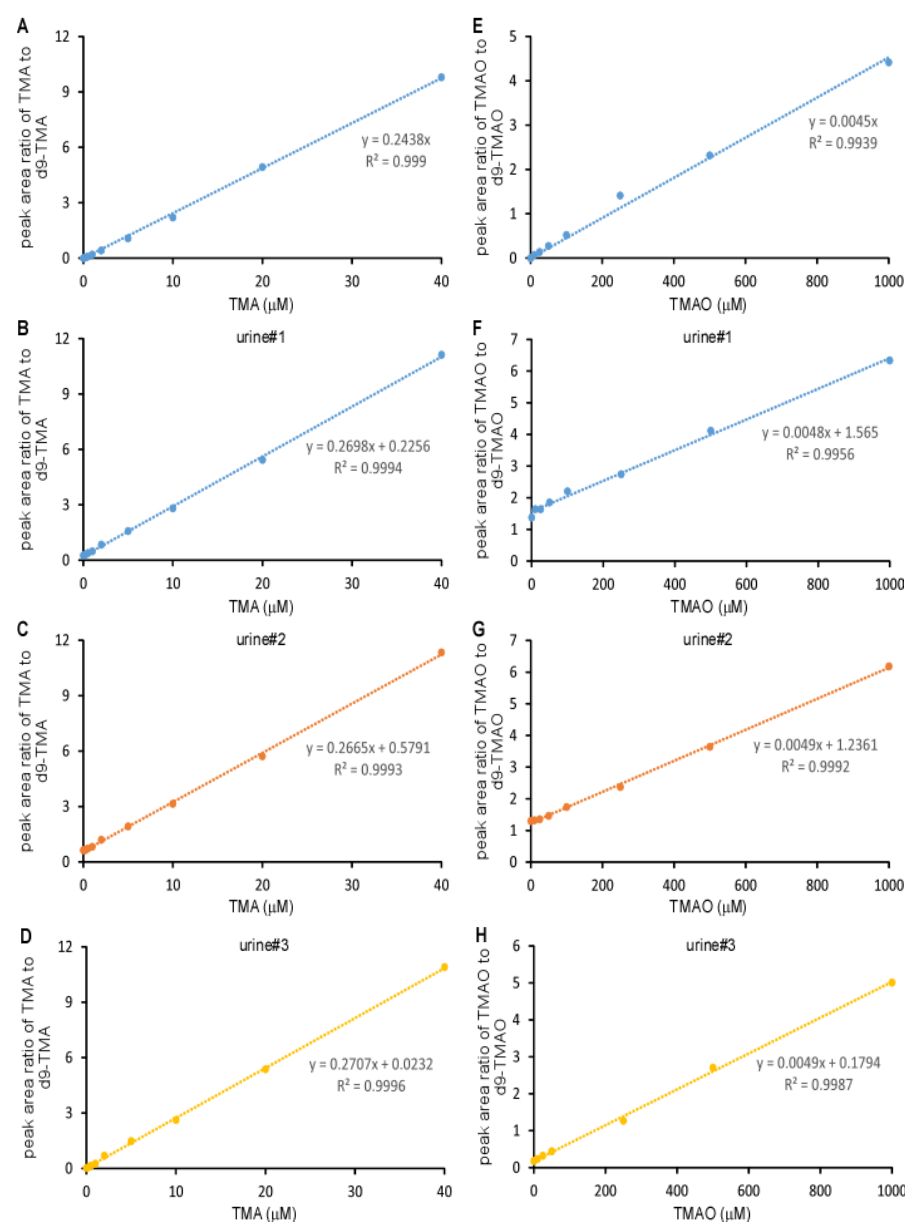
Figure 5. Standard curves for the LC/ESI/MS/MS analysis of the TMA and TMAO spiked into urine or non-urine control with d9-TMA and d9-TMAO as internal standards, respectively. Varying concentrations of TMA and TMAO standards were spiked into 3 urine samples or water. Then, 500 μL each was mixed with 20 μL of 1 mM d9-TMA and 1 mM d9-TMAO, extracted with 2 mL hexane and 1 mL butanol in the presence of 1 mL 0.5 N NaOH, and transferred to the aqueous phase by adding 0.2 mL 0.2 N formic acid. Curves were plotted as the peak area ratio of TMA to d9-TMA ( A – D ) and TMAO to d9-TMAO ( E – H ) versus concentration. Data were acquired in a Shimadzu 8050 LC/MS/MS with 2 μL sample injected into column.